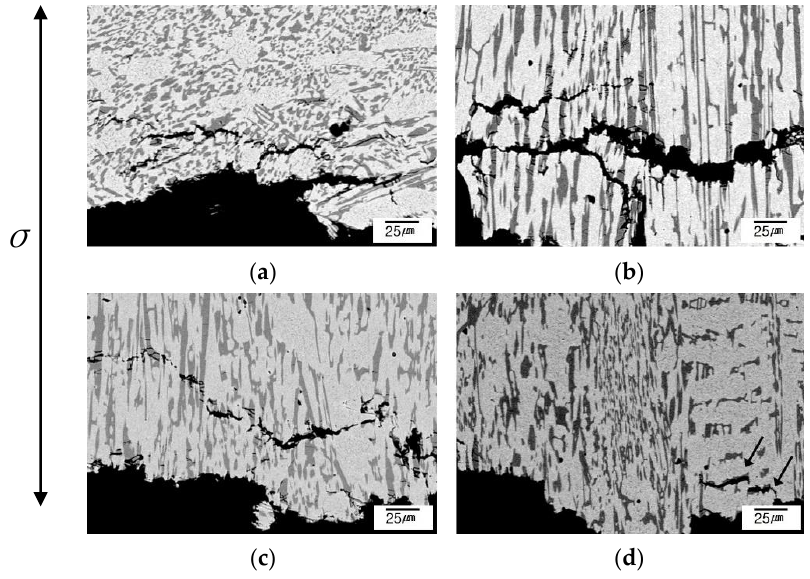
Figure 8. Microstructure at fractured tip of tensile specimen ( a ) equiaxed mother alloy ( b ) 10 µ m/s ( c ) 25 µ m/s ( d ) 50 µ m/s.